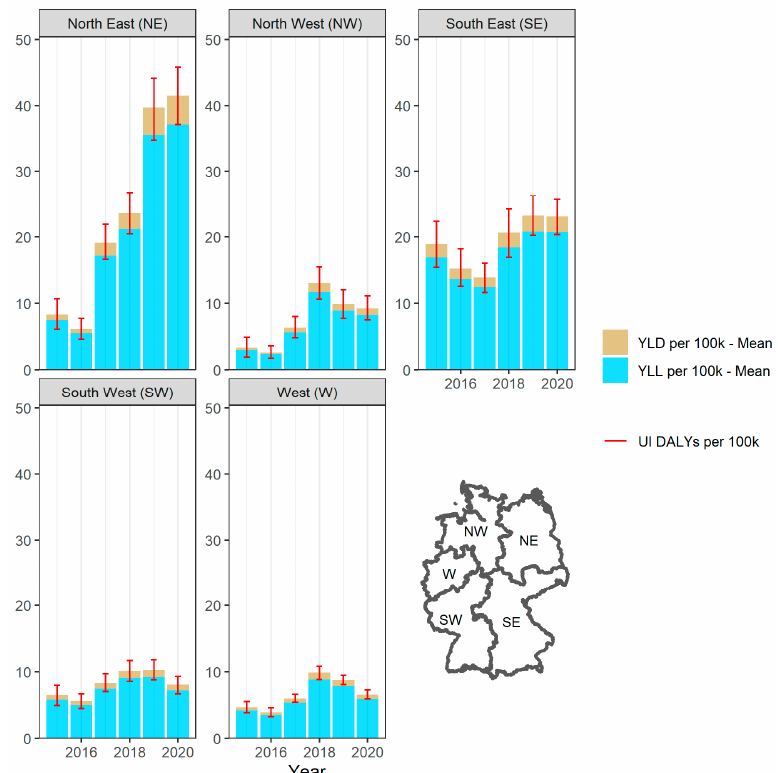
Figure 2. DALYs of bloodstream infections due to vancomycin-resistant Enterococcus faecium per 100,000 inhabitants, stratified by regions between 2015 and 2020 in Germany. UI: Uncertainty Intervals; YLL: Years of life lost; YLD: Years lived with disease.